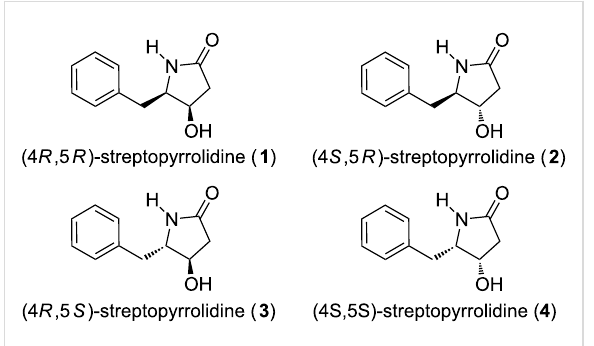
Figure 1: Structures of (4 R, 5 R )-streptopyrrolidine ( 1 ), (4 S, 5 R )-strepto- pyrrolidine ( 2 ) (4 R, 5 S )-streptopyrrolidine ( 3 ) and (4 S, 5 S )-strepto- pyrrolidine ( 4